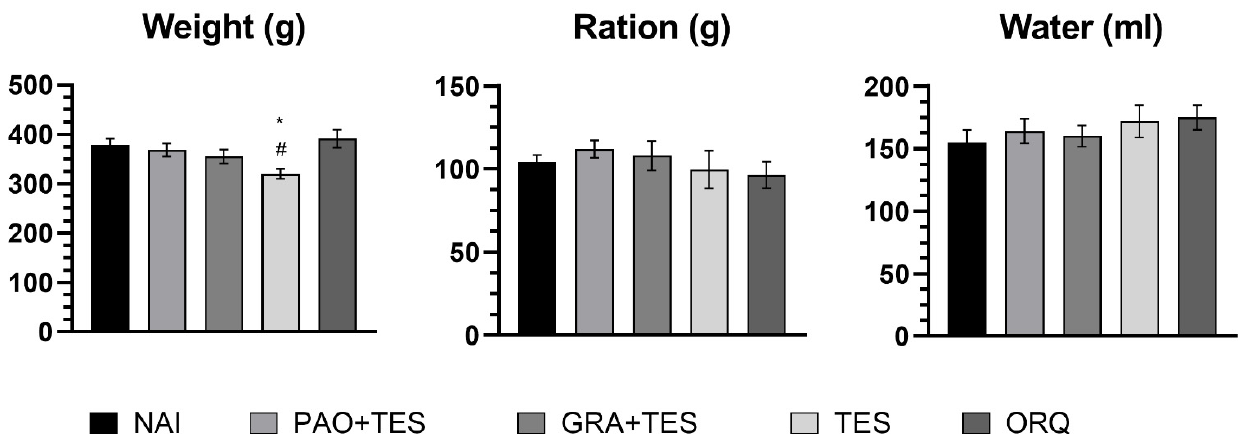
Figure 1. Effect of treatments over 45 days on weight, food intake, and water consumption. NAI: control naïve group; PAO + TES: orchiectomized group treated with purified annatto oil (200 mg/kg, p.o.) + testosterone (7 mg/kg, IM); GRA + TES: orchiectomized group treated with PAO granules (200 mg/kg, p.o., Chronic ® ) + testosterone (7 mg/kg, IM); TES: orchiectomized group treated only with testosterone (7 mg/kg, IM); ORQ: orchiectomized group treated only with water. *: p < 0.05 compared with ORQ; #: p < 0.05 compared with NAI.